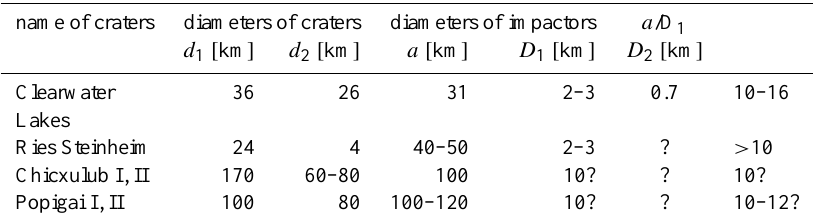
Table 3. Impactors and impacts.